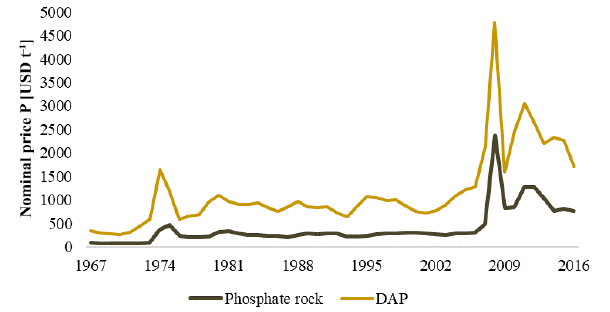
Figure 2. Nominal phosphate rock and DAP price trends (Index- Mundi, 2017). The rock phosphate and DAP price trend can be characterized as gradually increasing and being vulnerable to mar- ket dynamics (i.e. the 2007 global economic